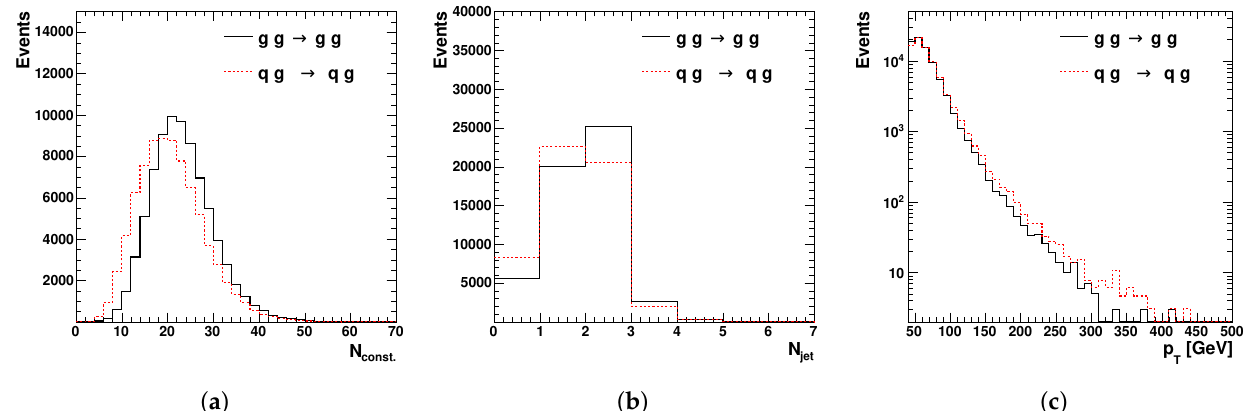
Figure 7. The comparison between several distributions for gg → gg and qg → qg processes. The pp collision events were generated using Pythia8 after parton showers followed by hadronization. ( a ) The distributions of the number of jet constituents (for all jets above p T = 40 GeV). ( b ) The distribution of the numbers of jets. ( c ) The transverse momentum of jets leading in p T